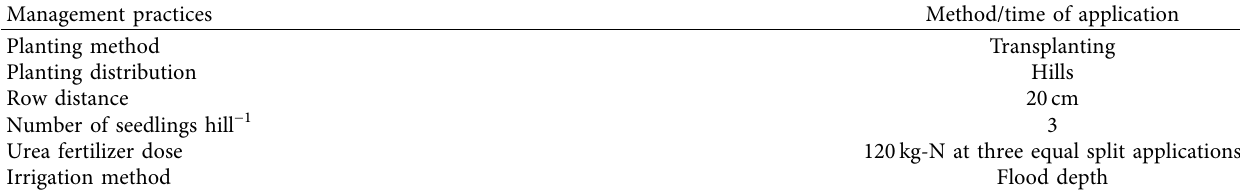
Table 3: Crop management options as input to DSSAT